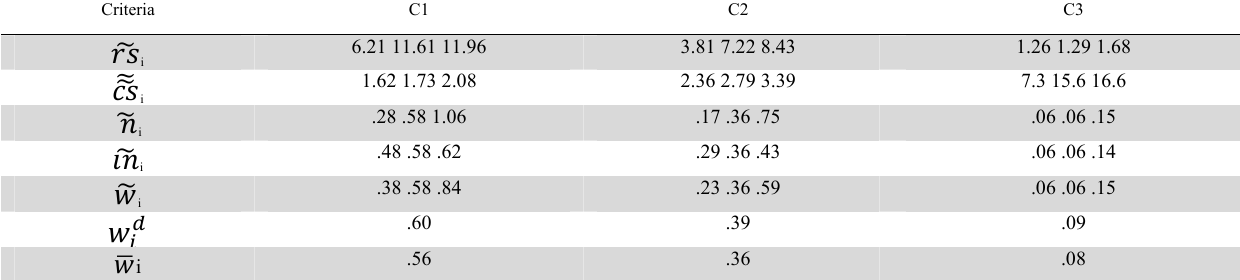
Final Weightages of the Critical Factors of HoQ Criteria